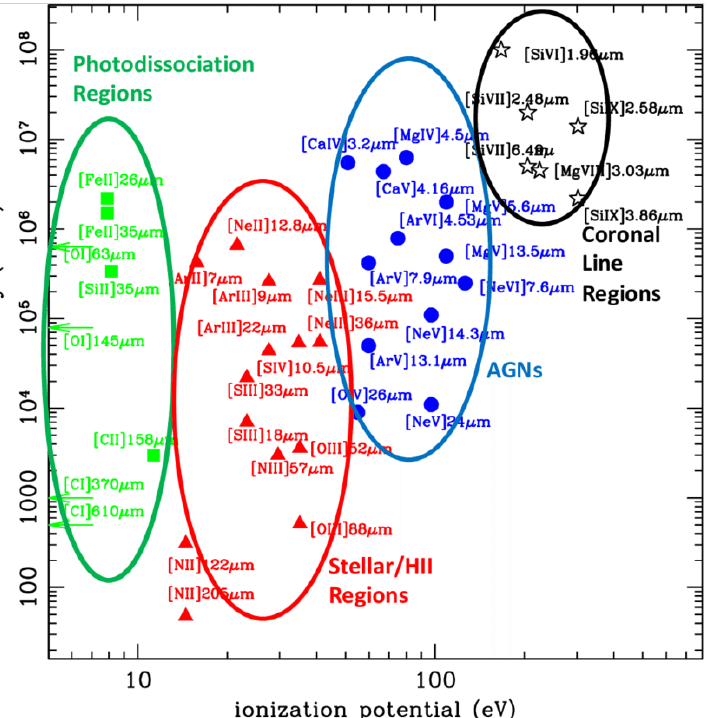
Figure 5. The wealth of mid-IR fine structure diagnostic lines. The ratio of lines from say the AGN group vs. from the HII group (e.g., [ N V ] / [ N II ] ) serve as diagnostics of the relative strength of AGN in a galaxy. Adapted from Spinoglio et al. [85], with permission from the